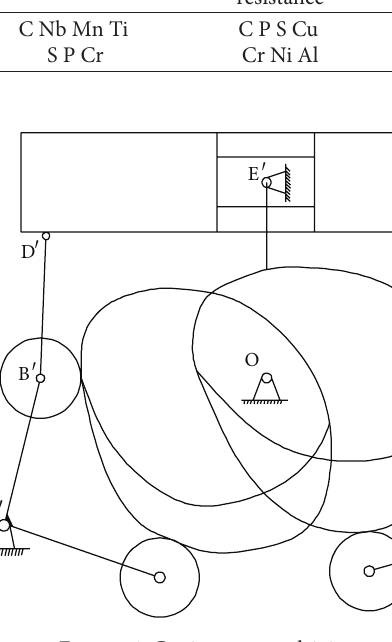
Figure 4: Conjugate cam driving